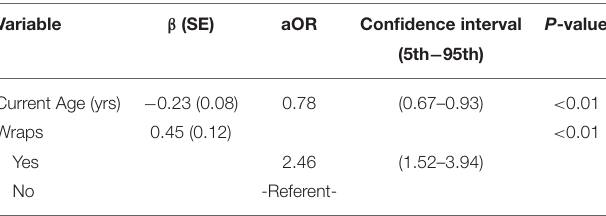
TABLE 4 | Results of final multivariable nominal regression model showing the effects of the remaining variables associated with injury in flyball dogs ( n = 375).